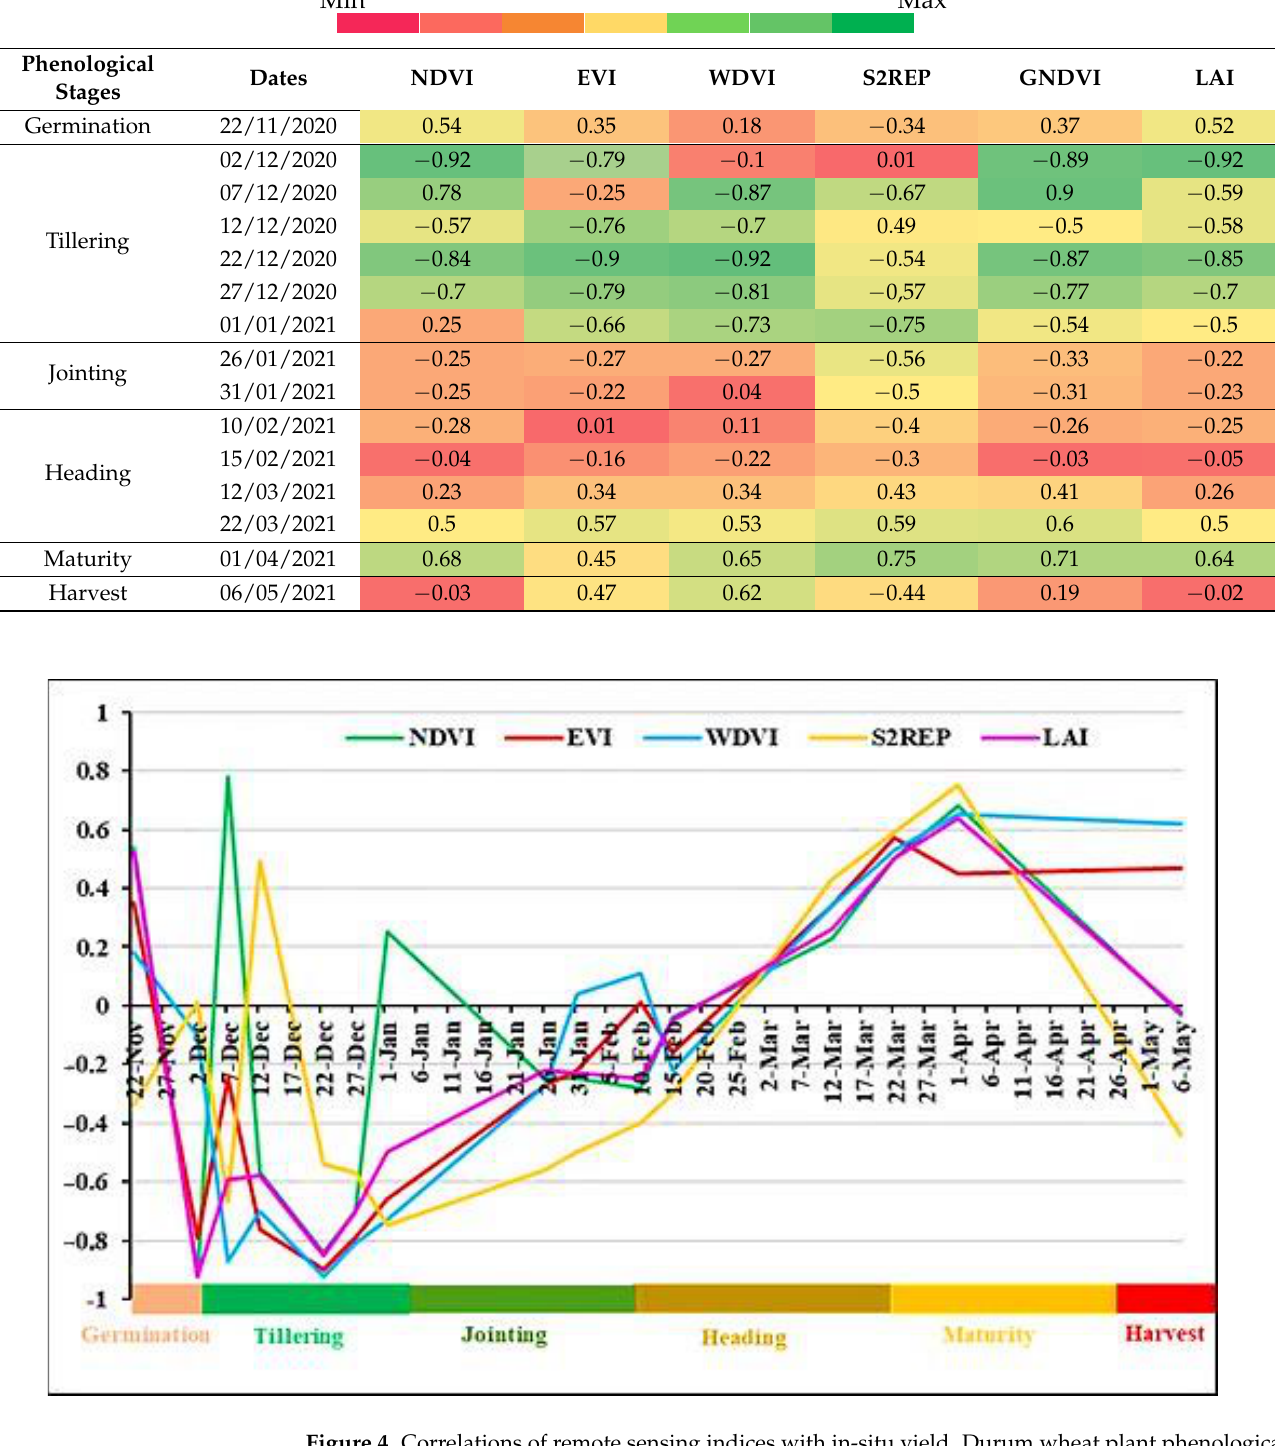
Figure 5. Sensitivity Analysis between Remote Sensing Indices and Crop Yield in the tillering stage (22 December 2020).